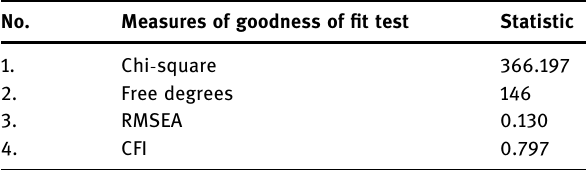
Table 7: The results of the suitability test for the third model